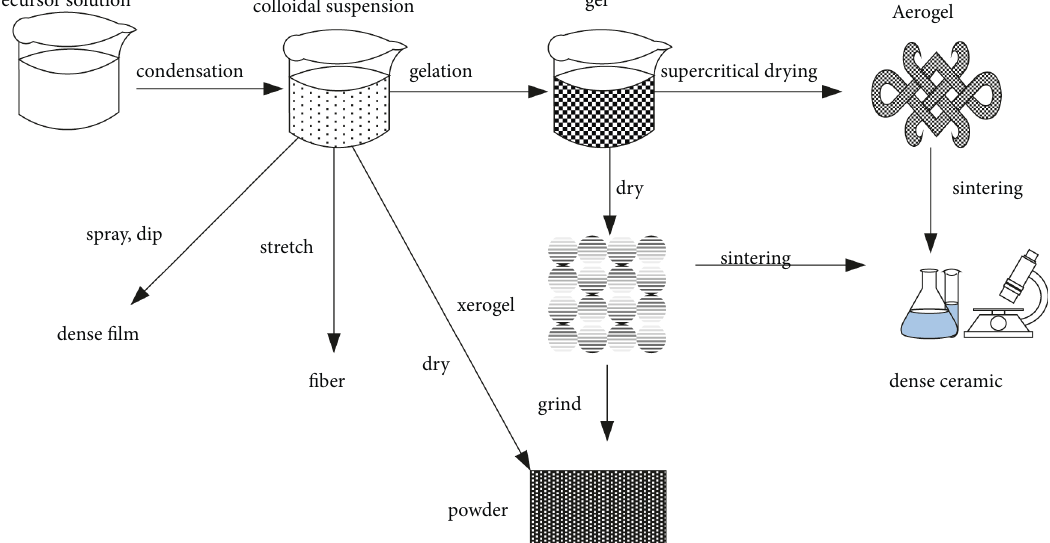
Figure 1: Schematic diagram of the whole process of the sol-gel